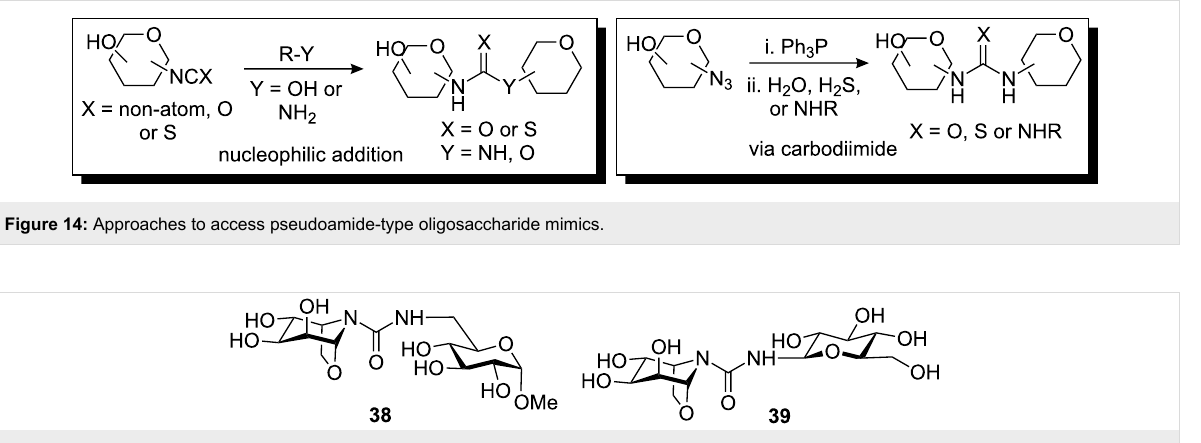
Figure 15: Calystegine B 2 analogues 38 and 39 with urea-linked disaccharide structure.